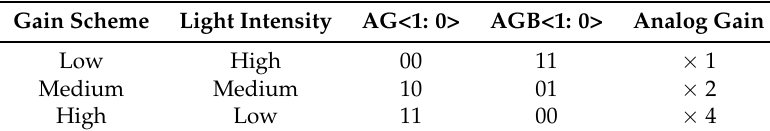
Table 1. Gain schemes and the control voltages.